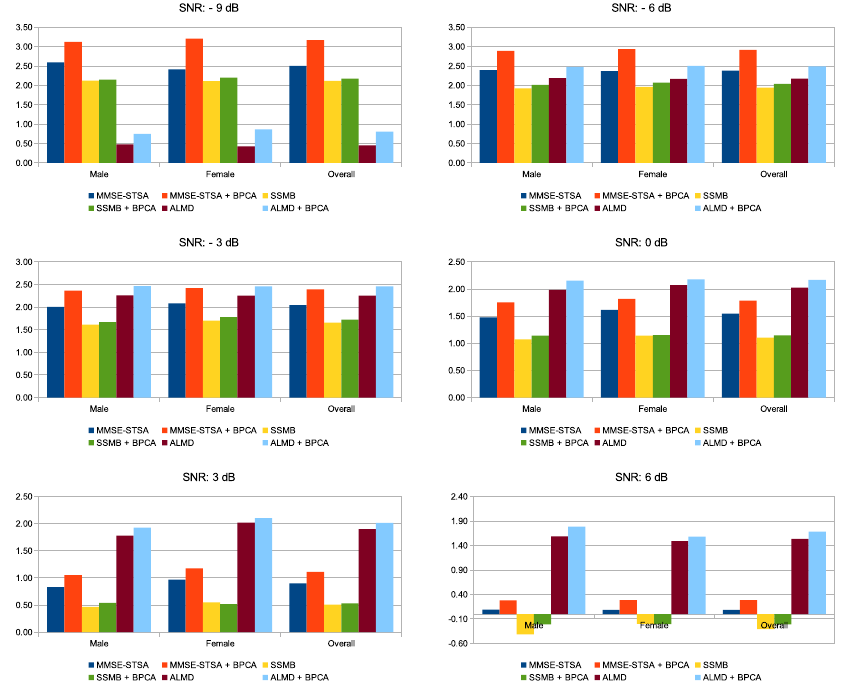
Figure 8. Average SSNR improvement in dB with regard to the noise floor scores for male and female speakers under ‘Babble’ noise contamination over multiple SNR levels. (For interpretation of the bar colors, the reader is referred to the web version of this